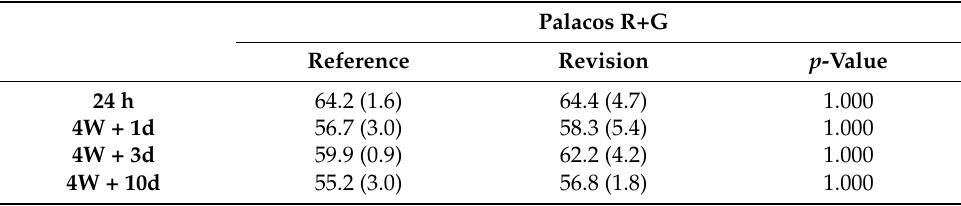
Table 2. Comparison of the bending strength of the Palacos R+G groups. Mean (SD) in MPa.